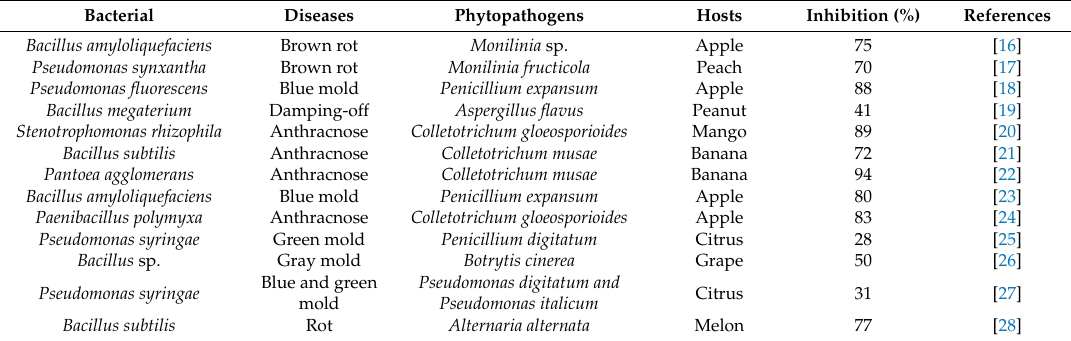
Table 1. Examples of biological control of postharvest disease by bacterial